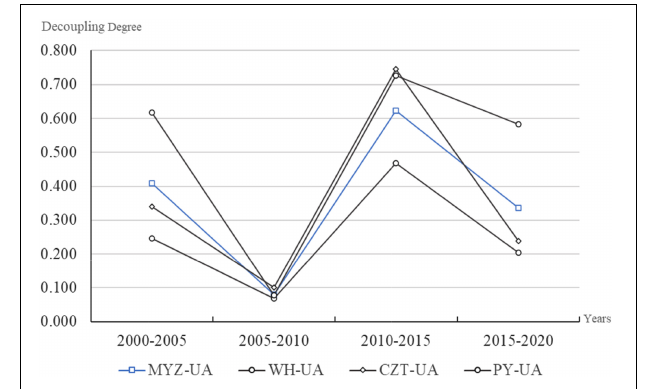
FIGURE 6 | Change in the decoupling degree of “construction land–economy” from 2000 to